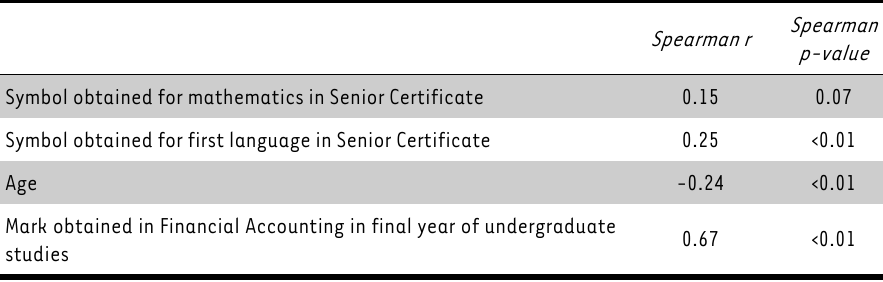
TABLE 2: Correlations with the mark obtained in